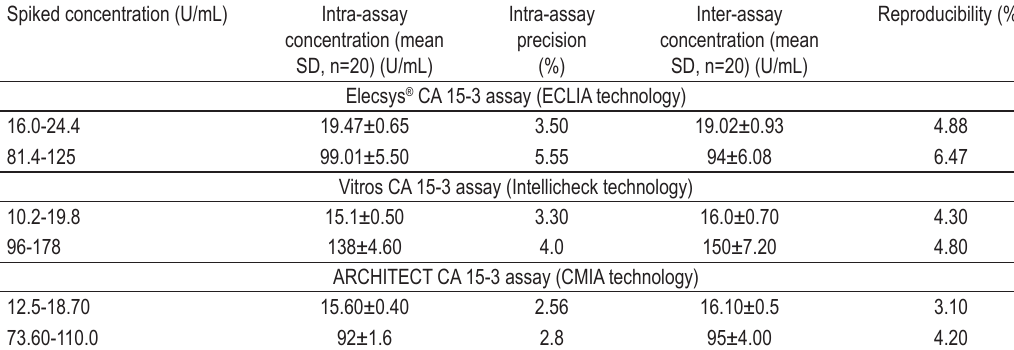
TABLE 1. Quality control testing Spiked concentration